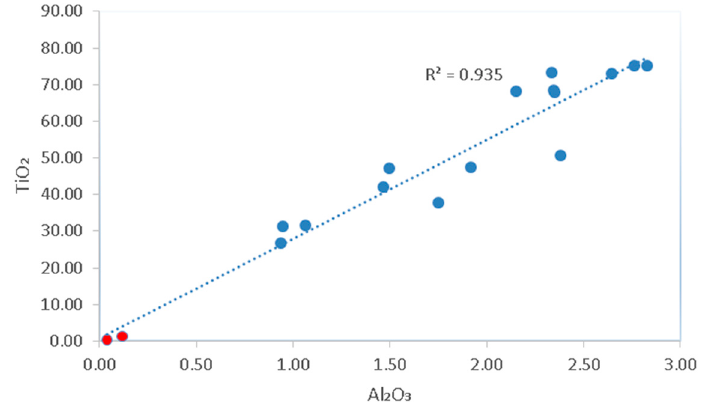
Figure 12. Scatter plot of TiO 2 versus Al 2 O 3 in the Dopolan deposit. Red circles are carbonate samples, blue circles are bauxite samples.